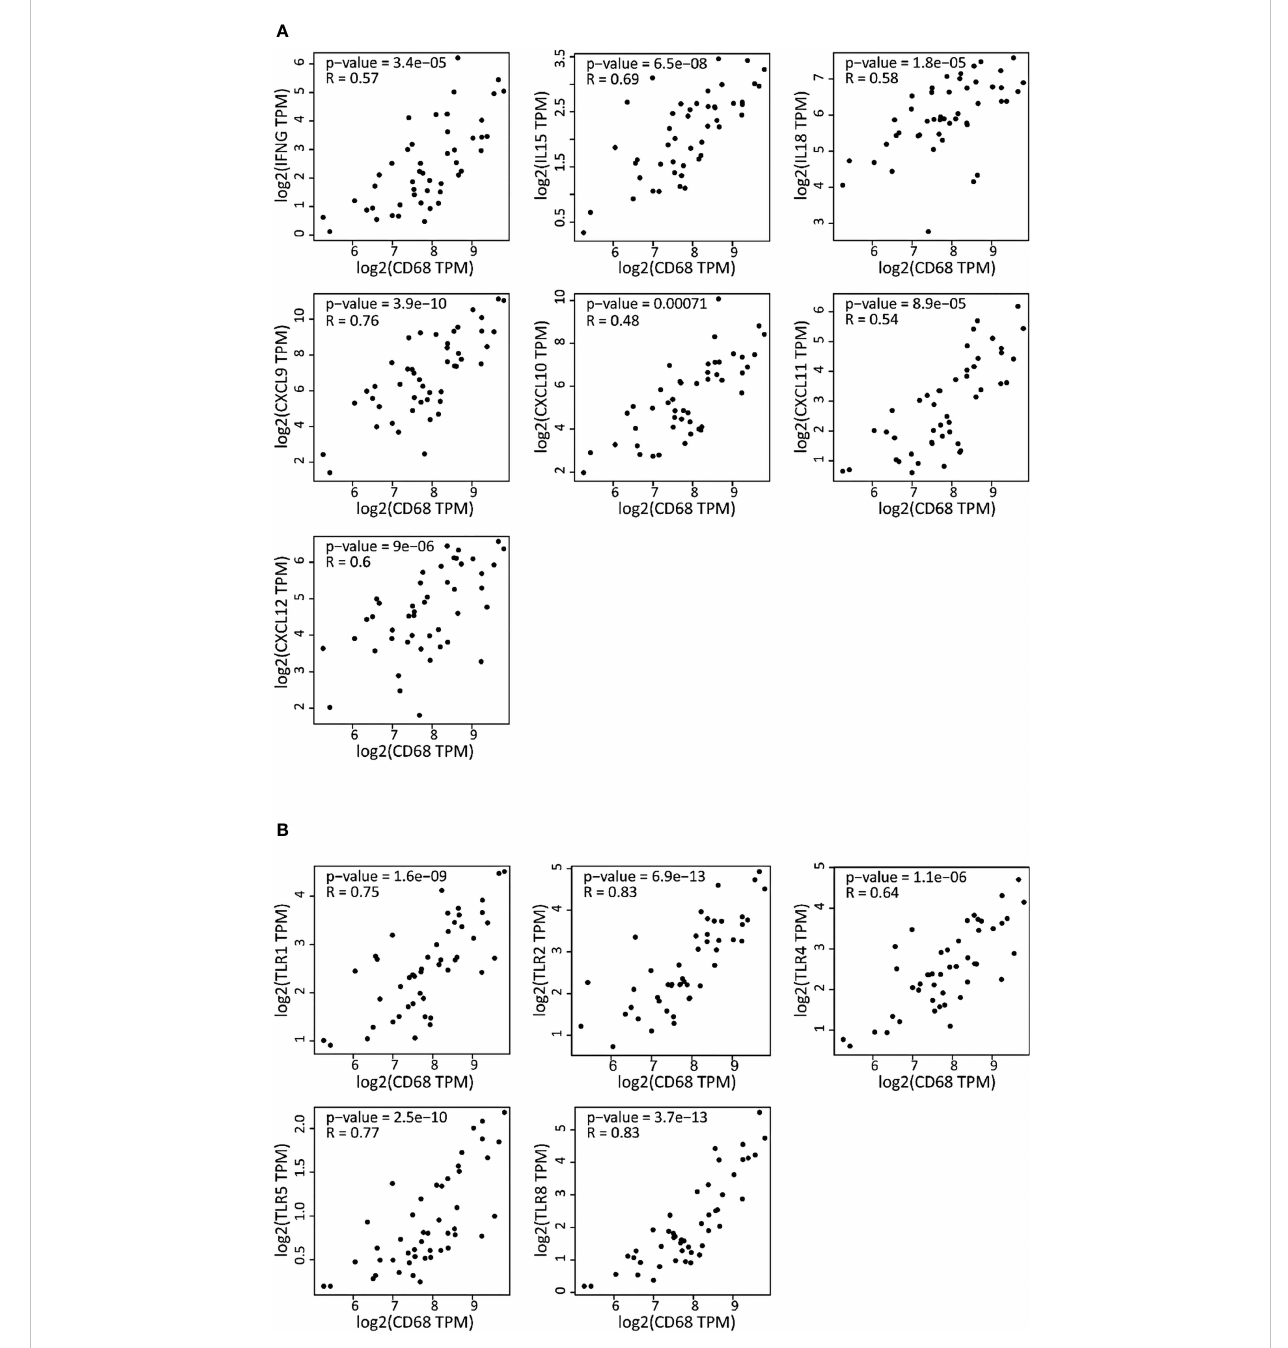
FIGURE 4 Correlation of the gene expression of cytokines and TLRs with the CD68 macrophage marker in DLBCL (A) Correlation between the gene expression levels of the indicated cytokines (interleukins, chemokines and chemokines receptors) and CD68 in 47 DLBCL samples (TCGA database). (B) Correlation between the gene expression levels of the indicated TLRs and CD68 in the same DLBCL samples. Quantitative comparison based on the Pearson ’ s correlation coef fi cient (R). Y-axis: log2 (TPM) of the indicated gene expression level, X-axis: log2 (TPM) of CD68 expression level. TPM, transcript count per million